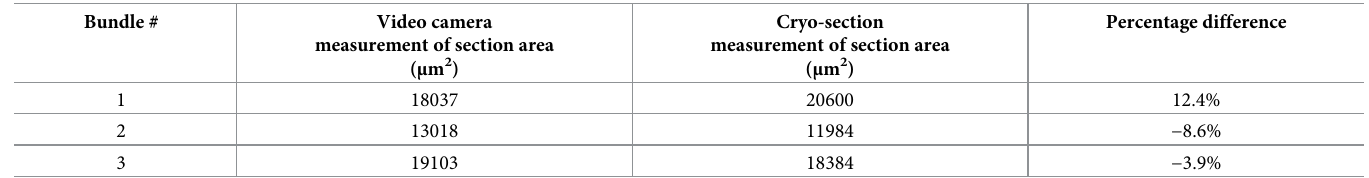
Table 1. Transversal section areas of bundles. Transversal section areas of three bundles, estimated from the video camera images assuming a circular cross-sectional area of each fibre and with image analysis on cross cryo-section of the same bundle. Bundle